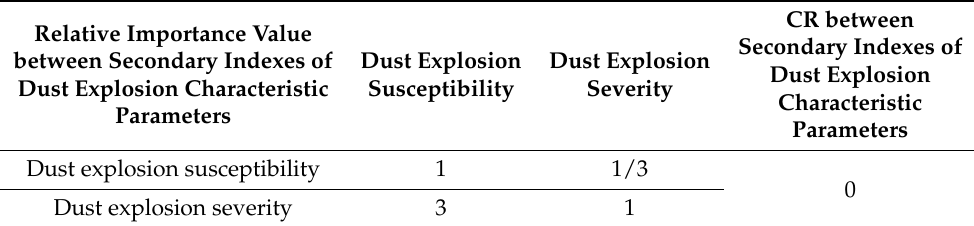
Table 8. Examples of experts’ judgment matrix and consistency test results for evaluation indexes between secondary indexes of dust explosion characteristic parameters.